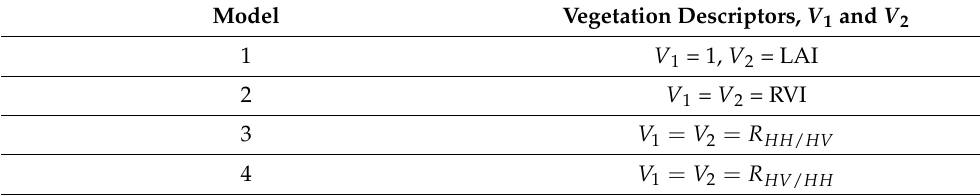
Table 2. Simplified WCM using modeled vegetation